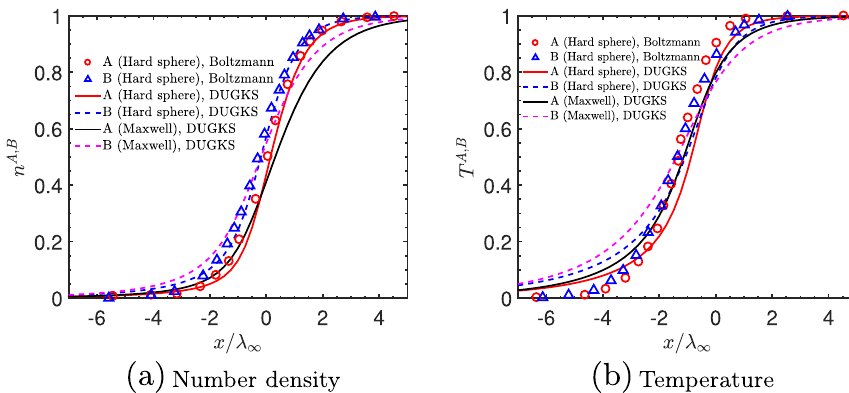
Fig. 11 Shock structure of different molecular models with Ma − = 3.0 , m B ∕ m A = 0.5 , and 𝜒 A =